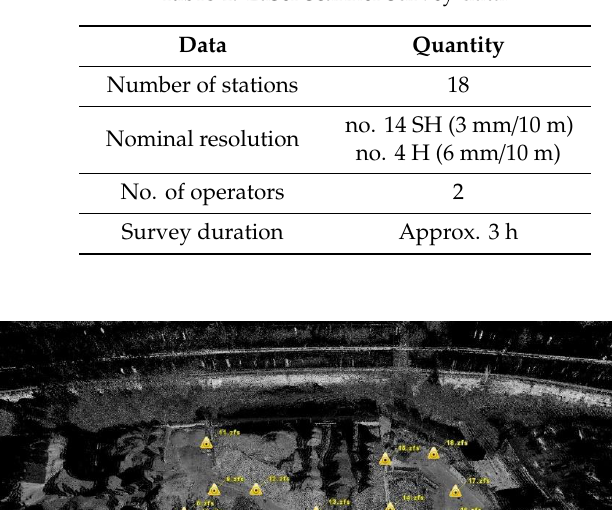
Table 1. Laser scanner survey data.